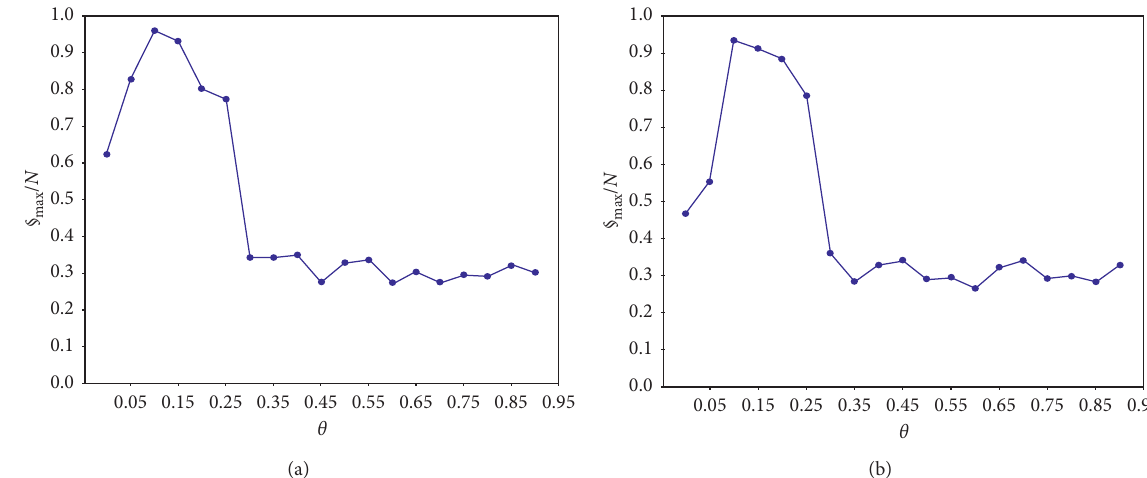
Figure 7: Distribution of S max /N under different similarity thresholds. The horizontal axis is the value of the similarity threshold, and the vertical axis is the S max /N value of the network at the last iteration. (a) ER network. (b) BA